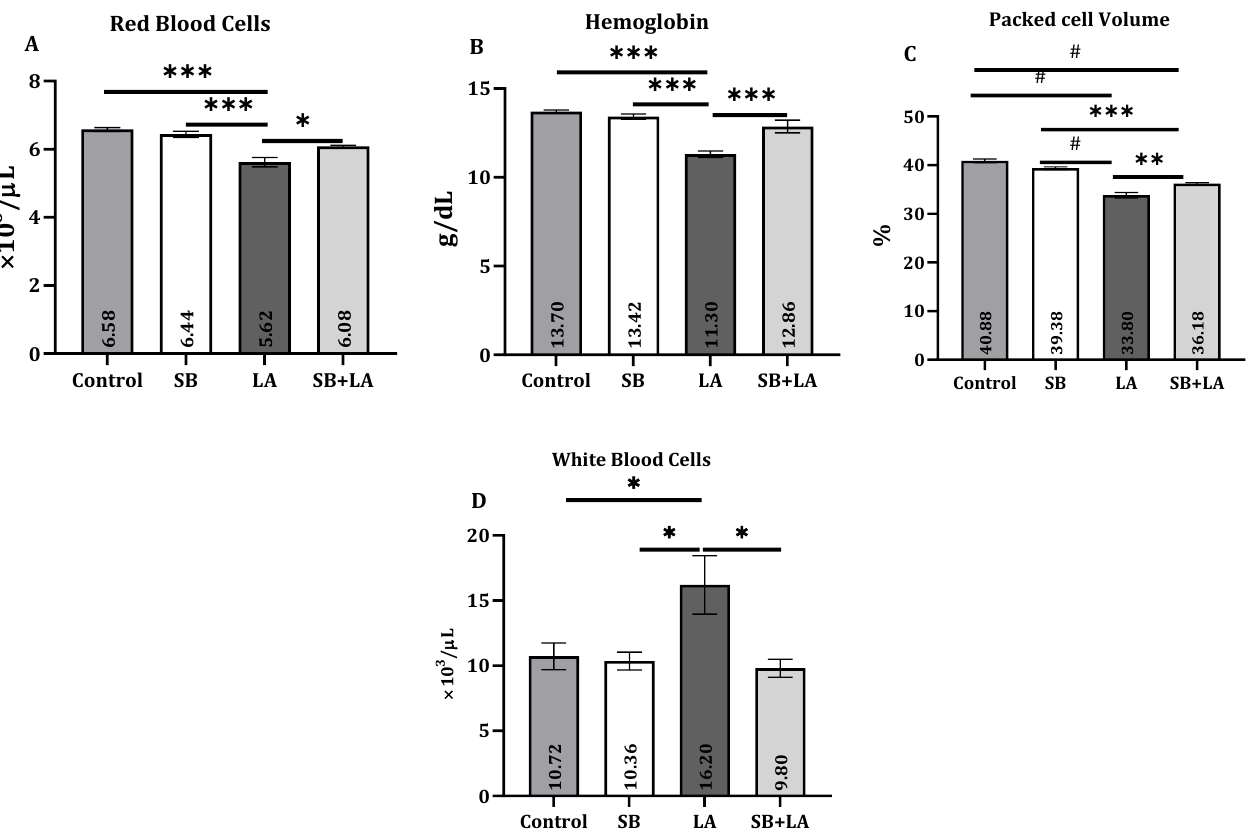
Figure 4 . Effect of sodium butyrate, Lead acetate, and their combination on ( A ) total red blood cells count (×10 6 µL), ( B ) hemoglobin (g/dL), ( C ) pocket cell volume (g/dL), and ( D ) total white blood cells count ((×10 3 µL) in adult female rats. Mean±SEM, n=10. Control, rats received only drinking water; SB, rats orally received sodium butyrate at 200 mg/kg BW; LA, rats orally received lead acetate at 50 mg/kg BW; SB+LA, rats orally received both sodium butyrate at 200 and lead acetate at 50 mg/kg BW. * P ≤0.05, ** P ≤0.01, ***P≤0.001, # P